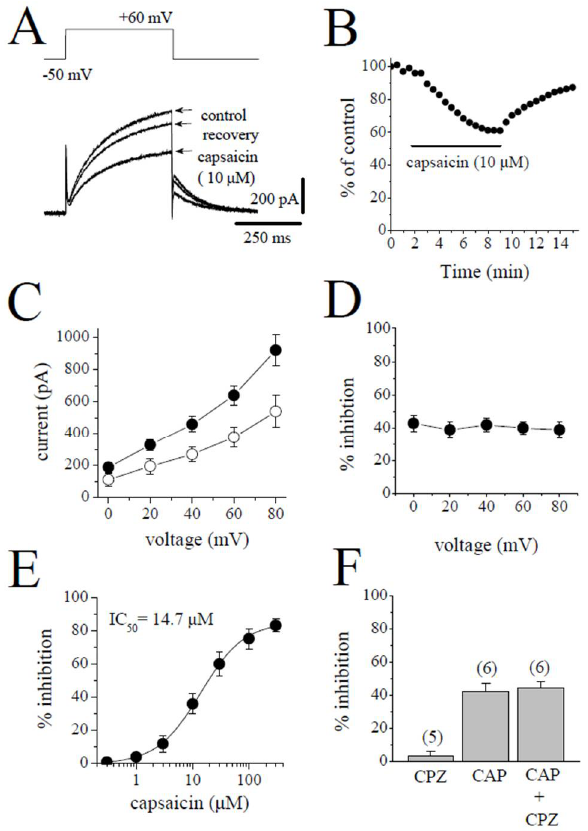
Figure 4. Capsaicin suppresses the I Ks component of the delayed rectifying I K . ( A ) Superimposed current traces in control, after 8 min exposure to 10 µ M capsaicin, and recovery. The pulse protocol to activate I Ks is shown as an inset. ( B ) Time course of the effect of capsaicin effect on the maximal amplitudes of I Ks and washout presented as % of control calculated from the mean of three control currents. ( C ) Current–voltage relationships of I Ks in the absence and presence of 10 µ M capsaicin are presented with filled and open circles, respectively ( n = 5). ( D ) The relationship between test potential and the capsaicin (10 µ M) inhibition of I Ks ( n = 5; p > 0.05, ANOVA). ( E ) Concentration-inhibition curve for capsaicin inhibition of I Ks ( n = 4–6). ( F ) The effect of capsazepine (3 µ M) and the extent of capsaicin (10 µ M) inhibition of I Ks in the absence and presence of 3 µ M capsazepine. The number of cells tested for each group was presented on top of each bar ( p > 0.05; t -test).